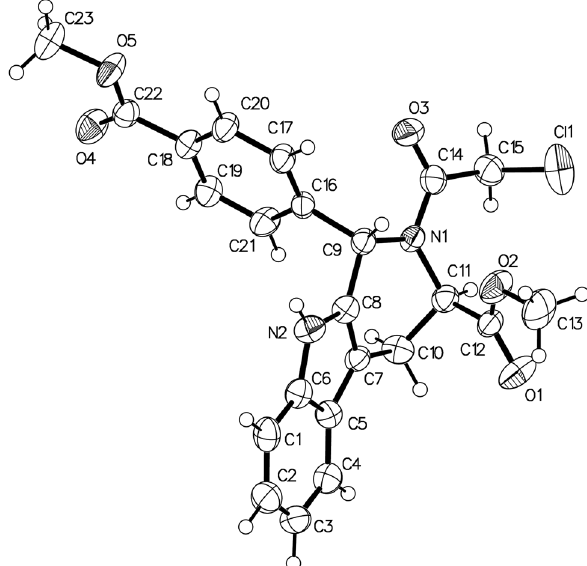
Table  : Data collection and